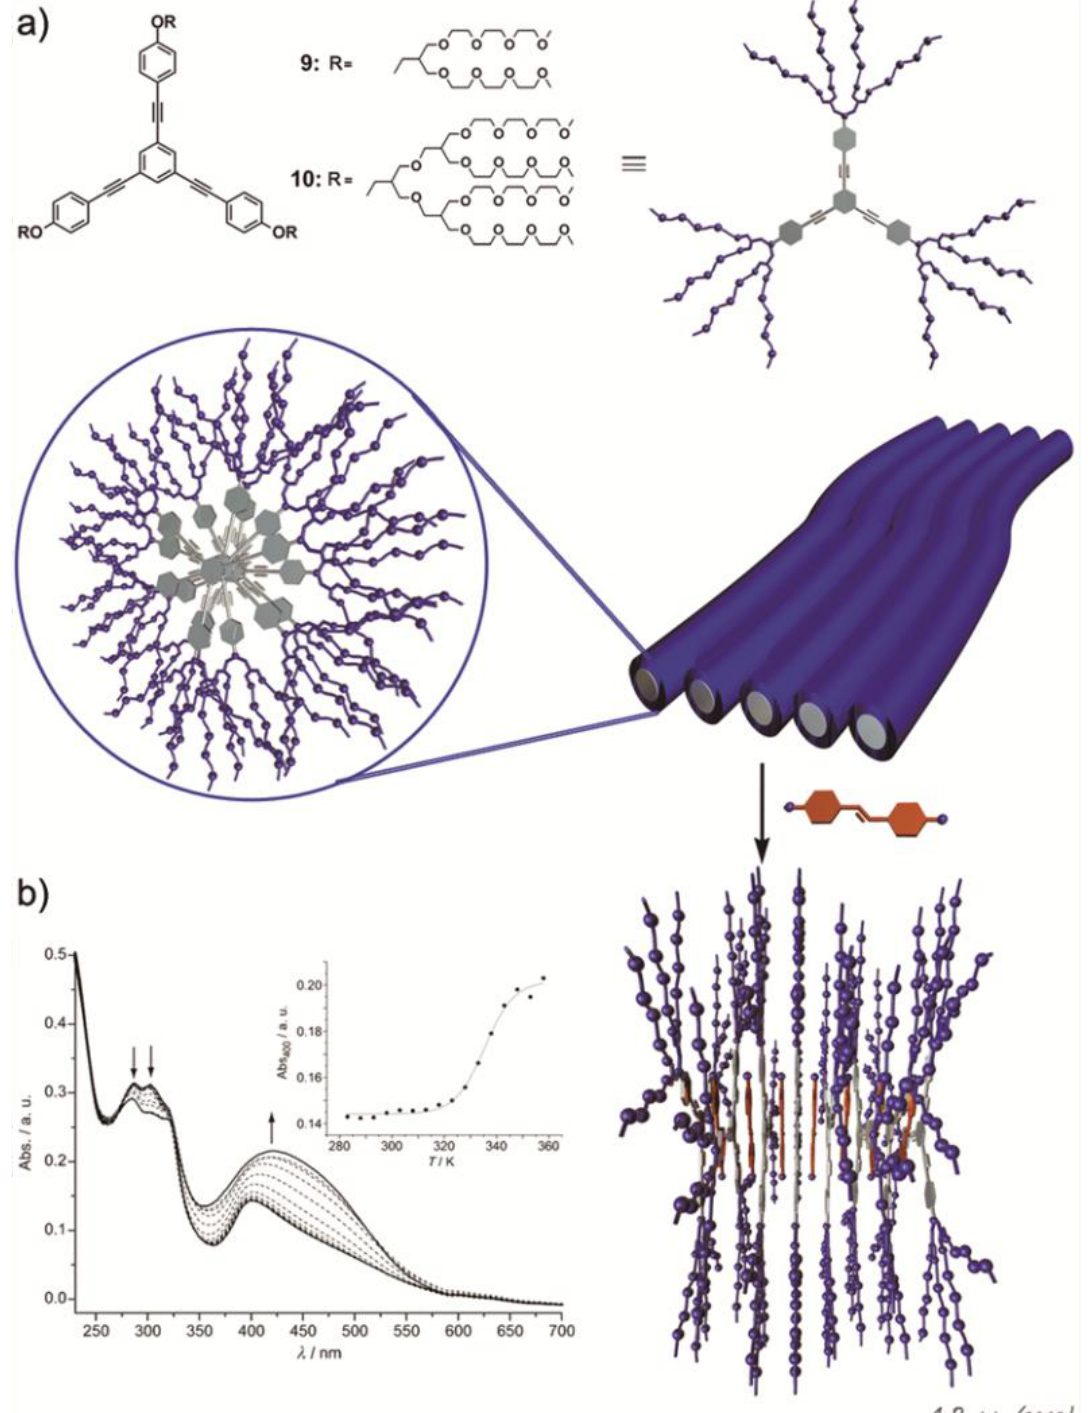
Figure 5. ( a ) Molecular structures of 9 and 10 and schematic representation of their self-assembly into nanofibrillar structures; ( b ) Temperature-dependent UV-Vis spectra of aqueous solutions (~10 −5 M) of 10 containing ten equivalents of Disperse Orange 3. Arrows indicate the spectroscopic changes upon increasing temperature. The inset depicts the changes in the absorbance at 400 nm as a function of temperature. Reprinted with permission from [21]. Copyright 2010